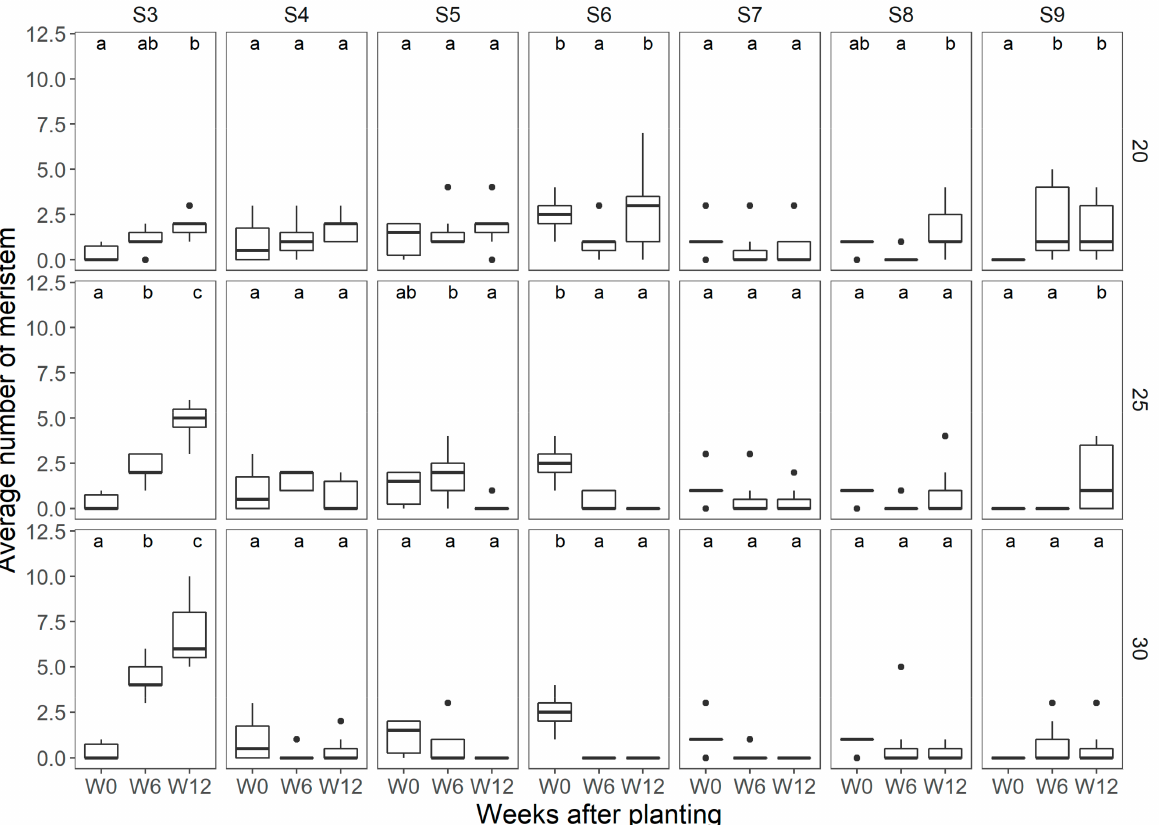
Figure 3. Average number of meristems observed per temperature treatment at each of the flower mapping occasions in ‘Florentina’, where W0 = week 0, W6 = week 6, and W12 = week 12 after start of treatment, at 20 ◦ C, 25 ◦ C, and 30 ◦ C, N = 7. The different letters above the boxplots in each box denote differences among means between the flower mapping occasions per temperature treatment, and similar lowercase letters indicate non-significant difference by the Holm − Sidak post-hoc test at 5% of error probability ( p <